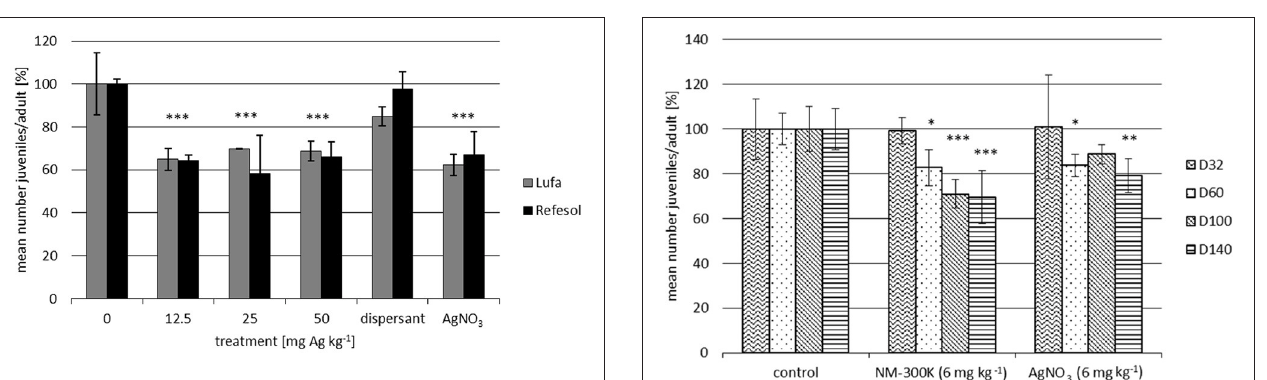
FIGURE 2 | Number of F. candida juveniles per adult normalized to the control (mean ± SE) after 28-day reproduction tests in LUFA 2.2 and RefeSol 01-A. The test was repeated twice and was performed with 5 replicates each. The nominal concentrations refer to mg Ag kg − 1 and the AgNO 3 treatment contained the same amount of silver as 50mg Ag kg − 1 NM-300K treatment. The dispersant control contained as much dispersant as the highest NM-300K treatment. Statistical significances to the respective control: *** p ≤ 0.001.